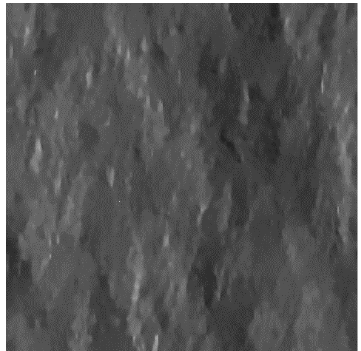
Figure 11. SB-SARBM3D with a priori scattering information estimated from the local incidence angle map in Figure 2b filtered with a 512 × 512 moving average filter and assuming the right values for the surface parameters.